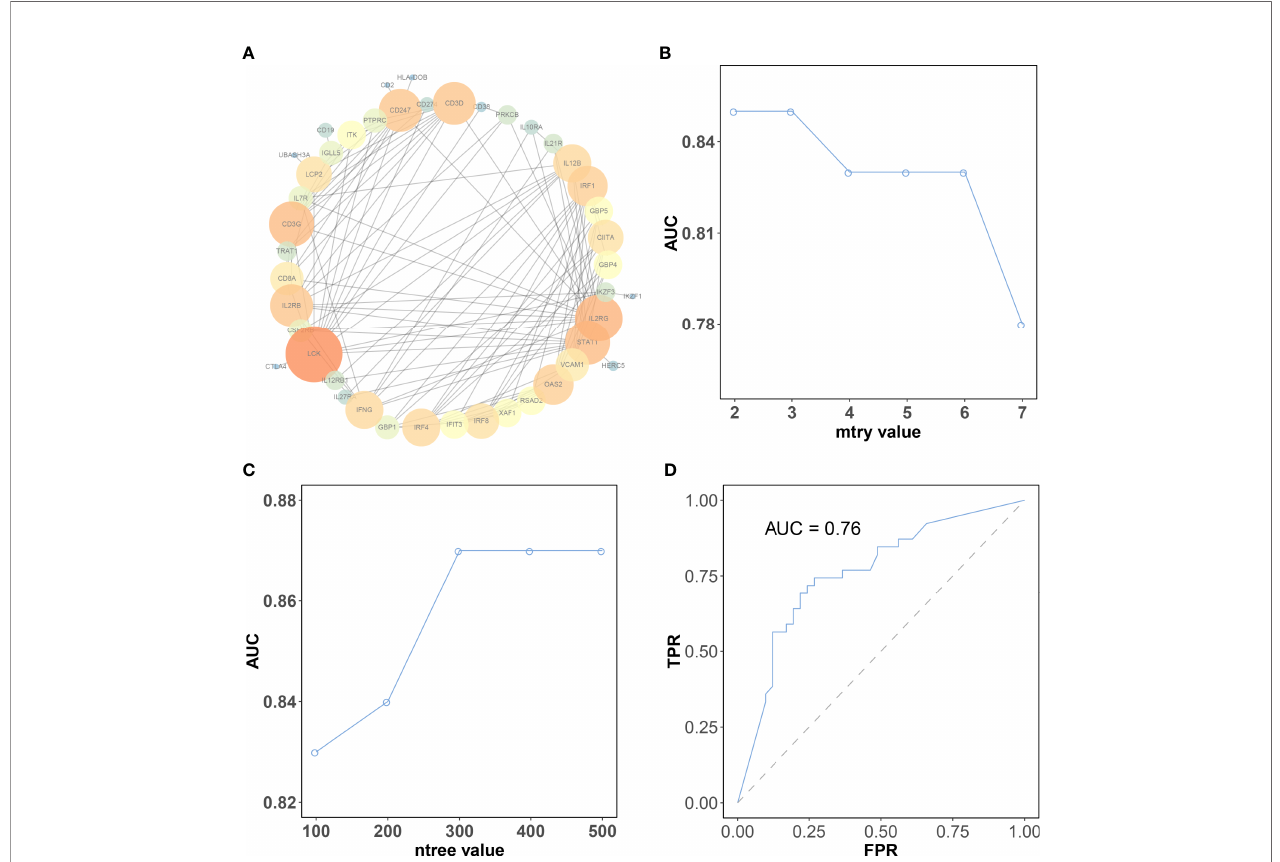
FIGURE 5 | The selection of the best parameter for the machine learning model. (A) Protein – protein interaction network of genes in the brown module. The color intensity and the size of nodes were positively correlated with the degree score. (B) The “ mtry ” with the highest AUC was selected as the optimal value of the random forest algorithm. (C) The “ ntree ” with the highest AUC was selected as the optimal value of the random forest algorithm. (D) Validation of model in the testing dataset. CR, complete response; PR, partial response; SD, stable disease; PD, progressive disease.